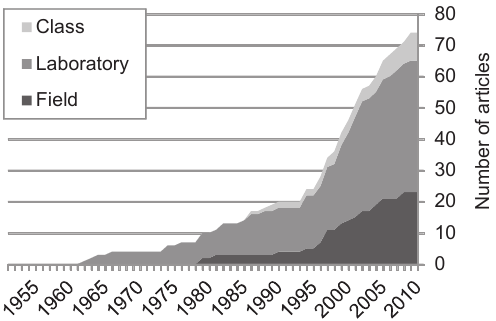
Fig. 1. Articles in the Journal of Geological Education (pre-1996) or Journal of Geoscience Education (post-1996) focusing on hydro- geology pedagogy either in the classroom, laboratory or